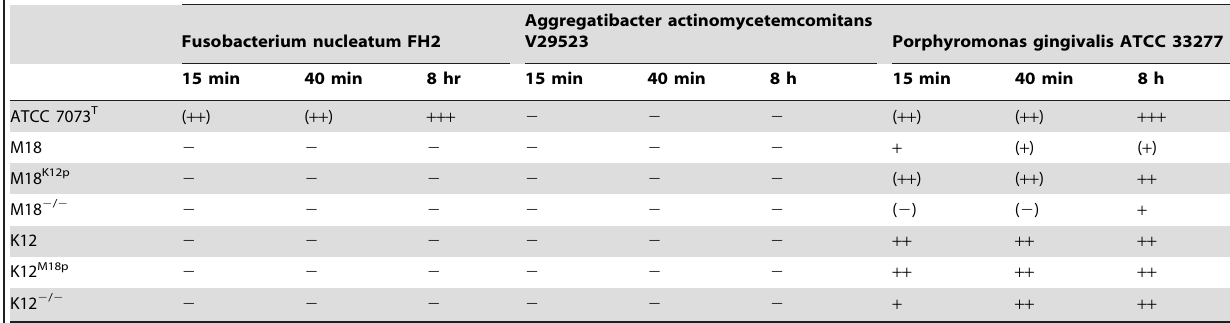
Table 3. The extent of co-aggregation of S. salivarius to periodontal